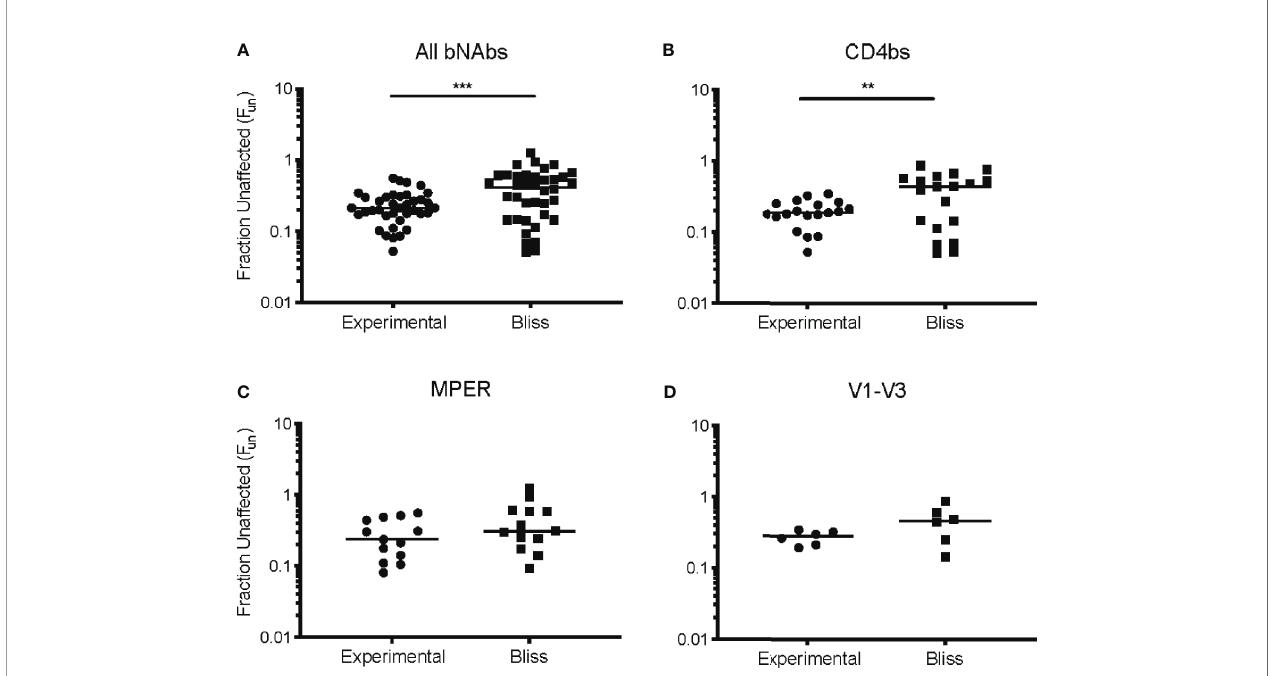
FIGURE 3 | CD4 binding site bNAbs and CD8 T cells act synergistically to suppress HIV replication. Experimental F un values from (A) all CD8+bNAb experiments, n = 38, (B) all CD4bs CD8+bNAb experiments, n = 19, (C) all MPER CD8+bNAb experiments, n = 13, and (D) all V1-V3 CD8+bNAb experiments, n = 6, were combined and compared to the predicted Bliss F un values for the same conditions. Each Bliss or Fun data point is calculated from the average of three technical replicates performed for each condition. The line indicates median and each point indicates an independent experiment or predicated value. Statistical analysis was performed using paired t tests, **p = 0.005 and ***p =